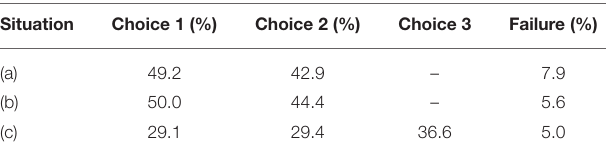
TABLE 2 | Ratios of chosen solutions for ambiguous cases (two or three acceptable answers) of bell task.